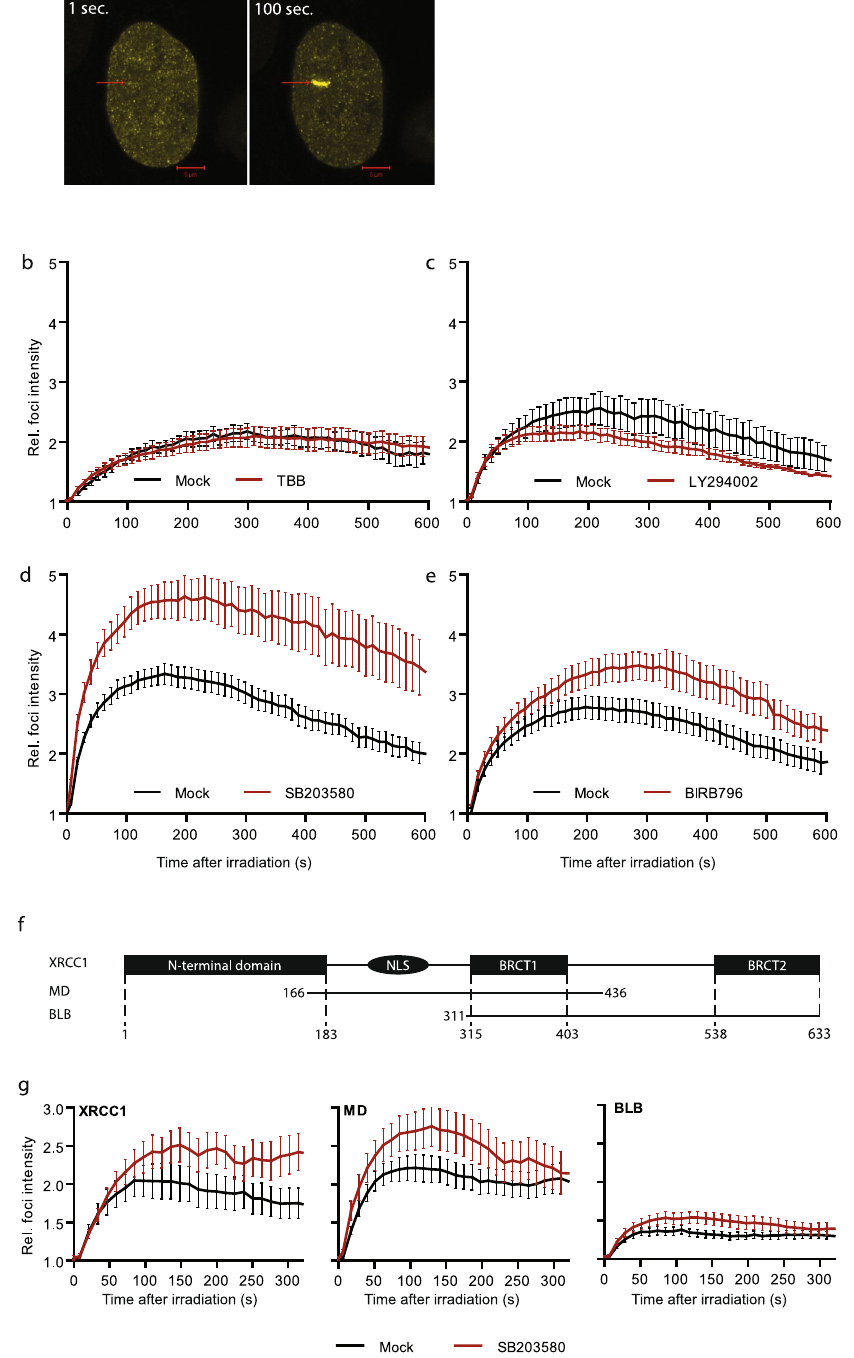
Figure 2. Recruitment of XRCC1-YFP and deletion mutants to micro-irradiated regions after kinase inhibitor treatment. ( a ) Untreated, freely cycling cells stably expressing XRCC1-YFP 1 s and 100 s after 405 nm micro- irradiation in a selected region (marked with arrow). Bars 5 µ M. ( b–e ) Average fold increase in mIF intensities of XRCC1-YFP in HeLa cells treated with either 0.25% DMSO (mock, black lines) or kinase inhibitors (red lines). Mean ± SEM is shown. ( b ) 25 µ M CK2 inhibitor TBB. Mock n = 4, TBB n = 9. (c) 25 µ M PI3K inhibitor LY294002. Mock n = 16, LY294002 n = 7. ( d ) 25 µ M p38 MAPK inhibitor SB203580. Mock n = 12, SB203580 n = 12. ( e ) 25 µ M p38 MAPK inhibitor BIRB0796. Mock n = 11, BIRB0796 n = 16 ( f ) Schematic overview of full length XRCC1 and deletion mutants. ( g ) Average fold increase in mIF intensities of full-length XRCC1- YFP (left panel), YFP-MD (middle panel) and YFP-BLB (right panel) deletion mutants in CHO EM9 cells in absence (black line) and presence of 25 µ M SB203580 (red line). The graphs representing the mutants in absence of SB203580 have previously been published 29 . XRCC1: Mock n = 15, SB203580 n = 11. MD: Mock n = 15. SB203580 n = 16. BLB: Mock n = 20, SB203580 n =